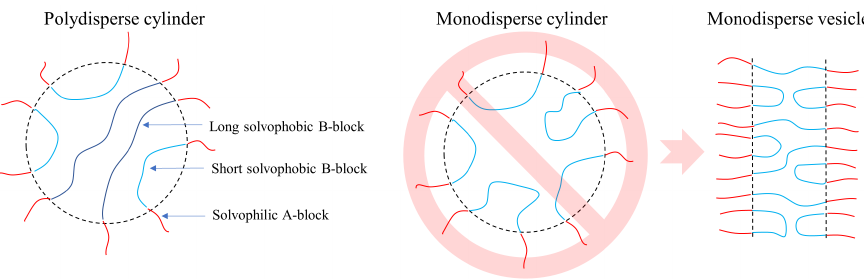
Figure 4. Schematic representation of the packing of ABA triblock copolymers inside